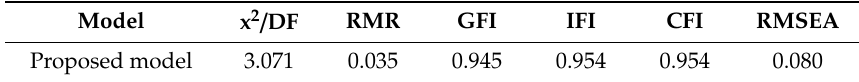
Table 7. Goodness-of-fit indices for the study